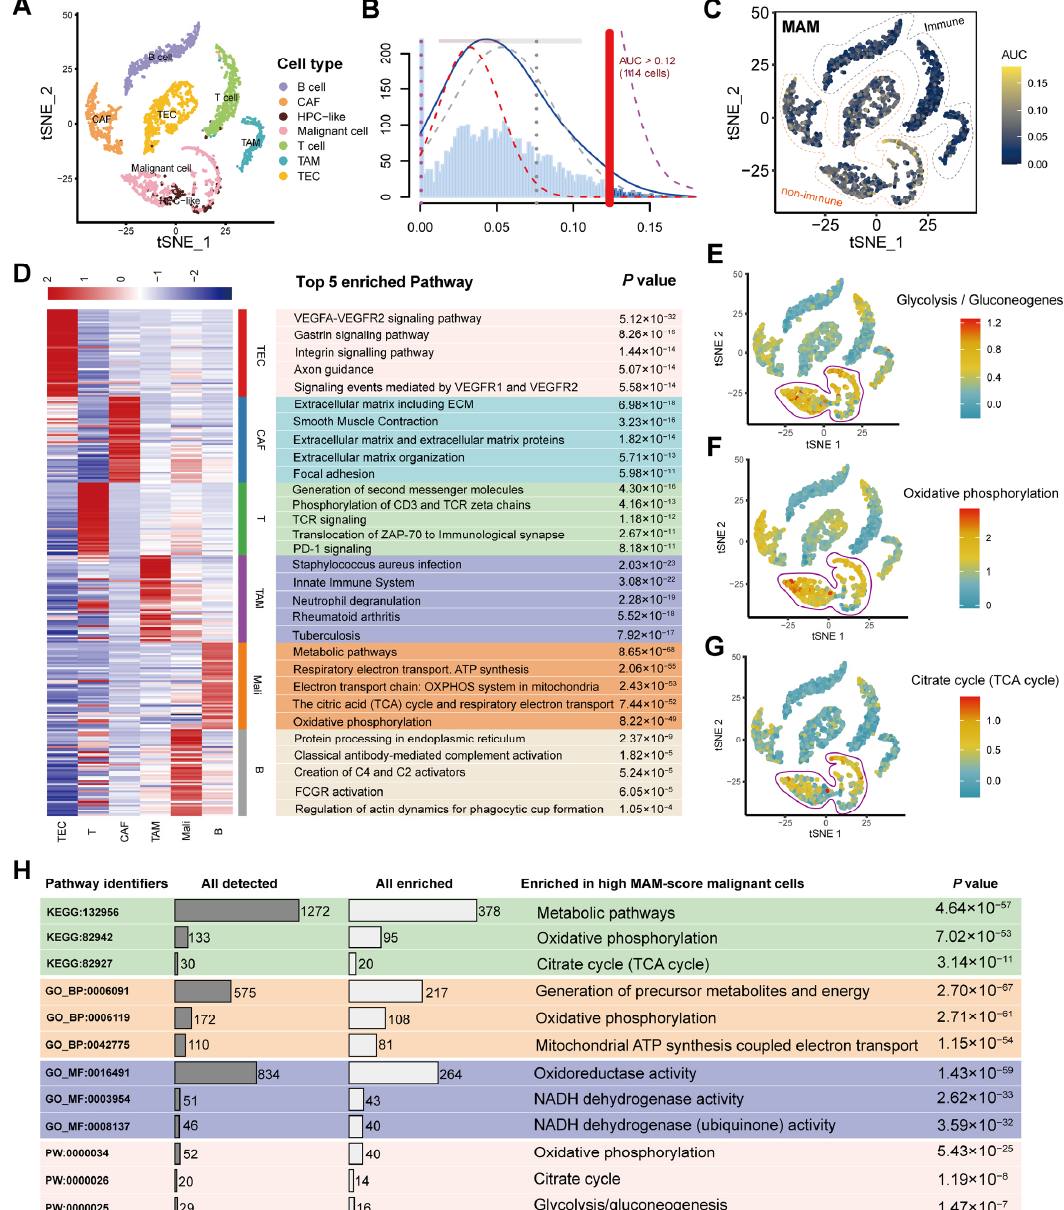
Figure 4. Identi fi cation of the MAM score and its potential enriched pathways at the single-cell level. ( A ): T-SNE visualization of various cell types. ( B ): Frequency of calculating the MAM scores by AUCell analysis. ( C ): AUC of MAM score visualized by T-SNE. ( D ): Top 5 enrichment pathways